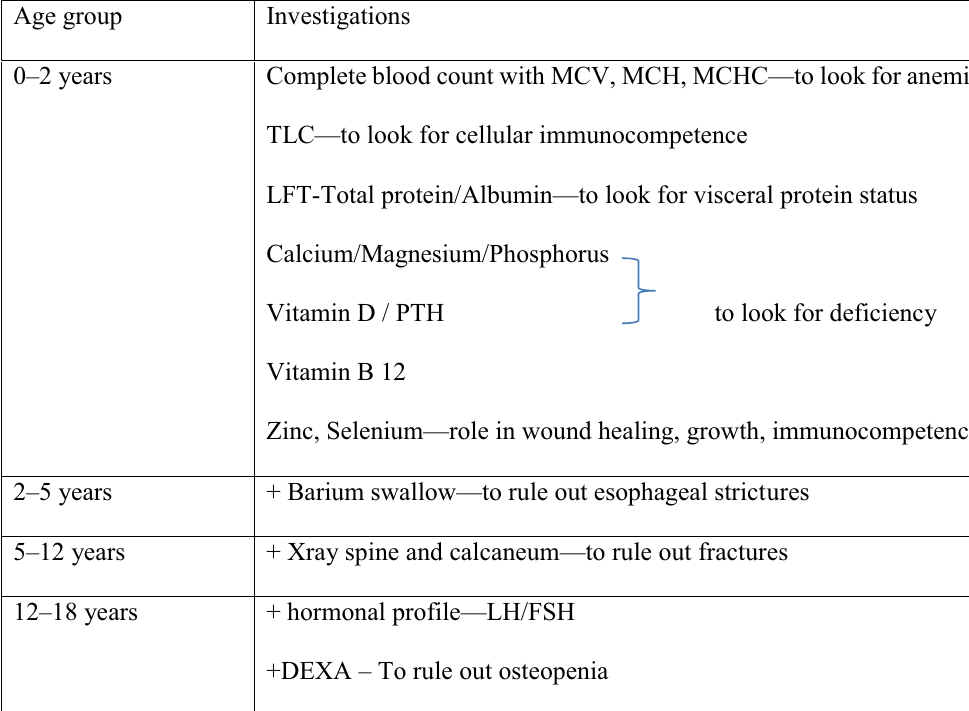
Table 1. List of laboratory investigations undertaken in the study cohort. MCV Mean corpuscular volume, MCH Mean corpuscular hemoglobin, MCHC Mean corpuscular hemoglobin concentration, TLC Total leucocyte count, LFT Liver function test, PTH Parathyroid hormone, LH Luteinizing hormone, FSH Follicle- stimulating hormone, DEXA Dual-energy X-ray